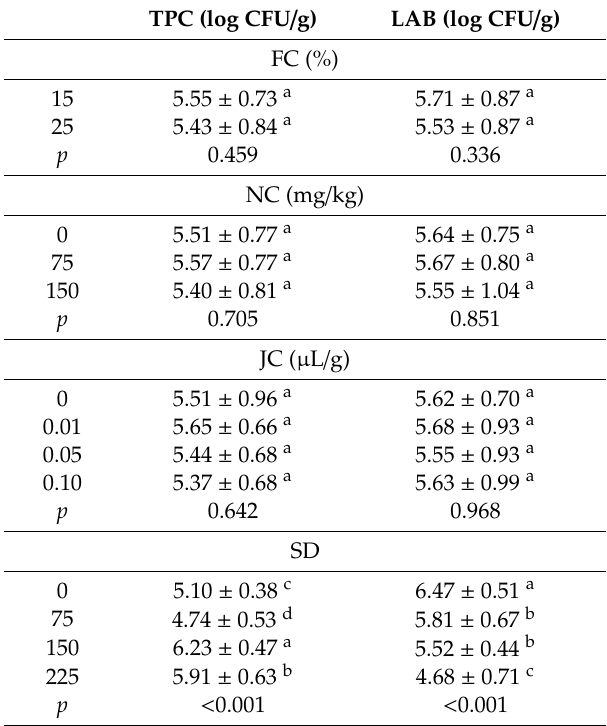
Table 3. Microbiological quality of dry fermented